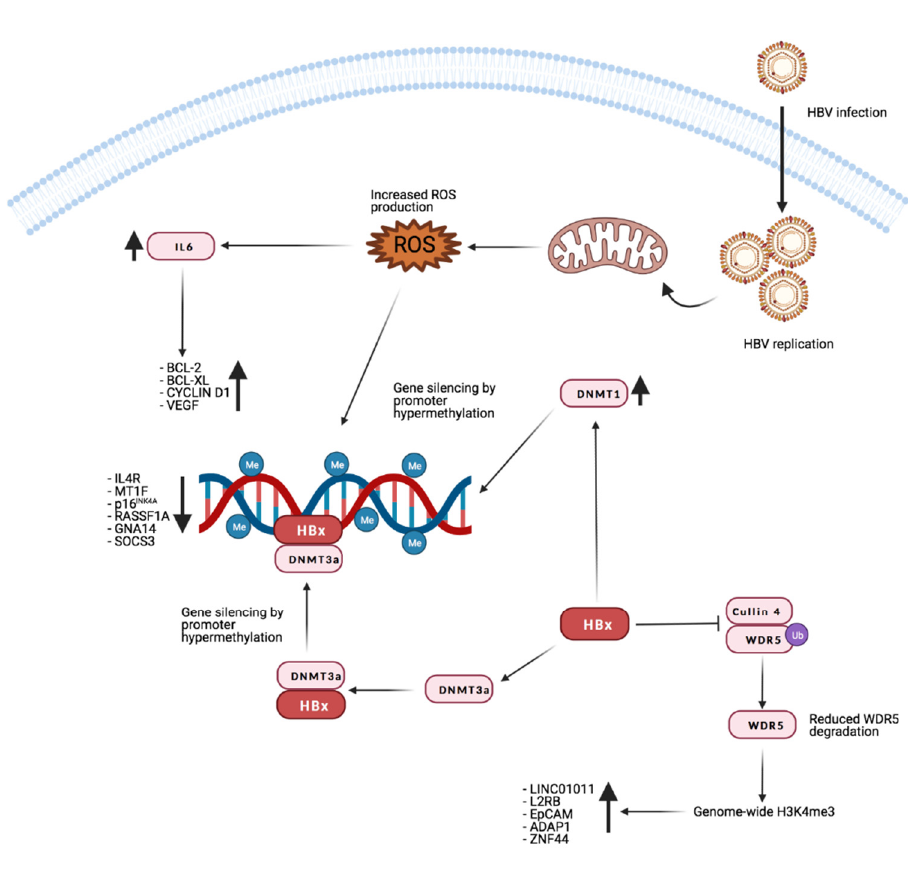
Figure 2. Effects of HBx on host methylation patterns. The viral protein HBx causes silencing of tumor suppressor genes by inducing repressive promoters hypermethylation through different mechanisms (see text for detailed description). At the same time, by inhibiting WDR5 degradation, it promotes the expression of target genes such as long intergenic non-protein- coding RNA 1011 (LINC01011), interleukin 2 receptor subunit beta (IL2RB), epithelial cell adhesion molecule (EpCAM), ArfGAP with dual PH domains 1 (ADAP1), and zinc finger protein 44 (ZNF44). Credits: Created with